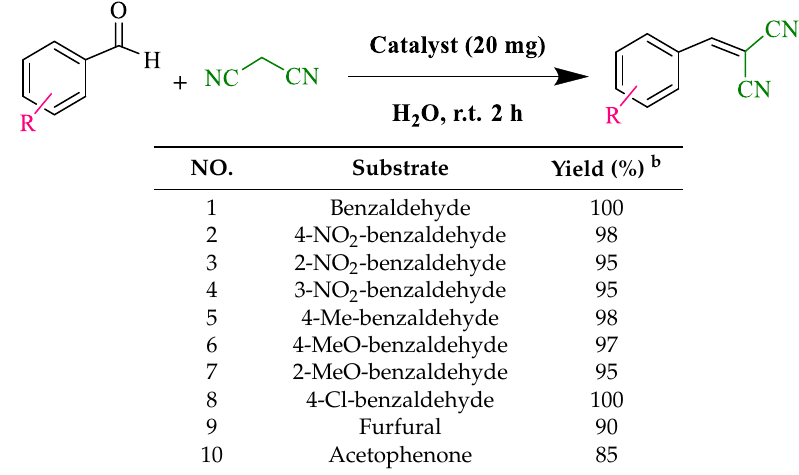
Table 1. Knoevenagel condensation reactions of various aldehydes with malononitrile catalyzed by BC@GCN-P-IL a .